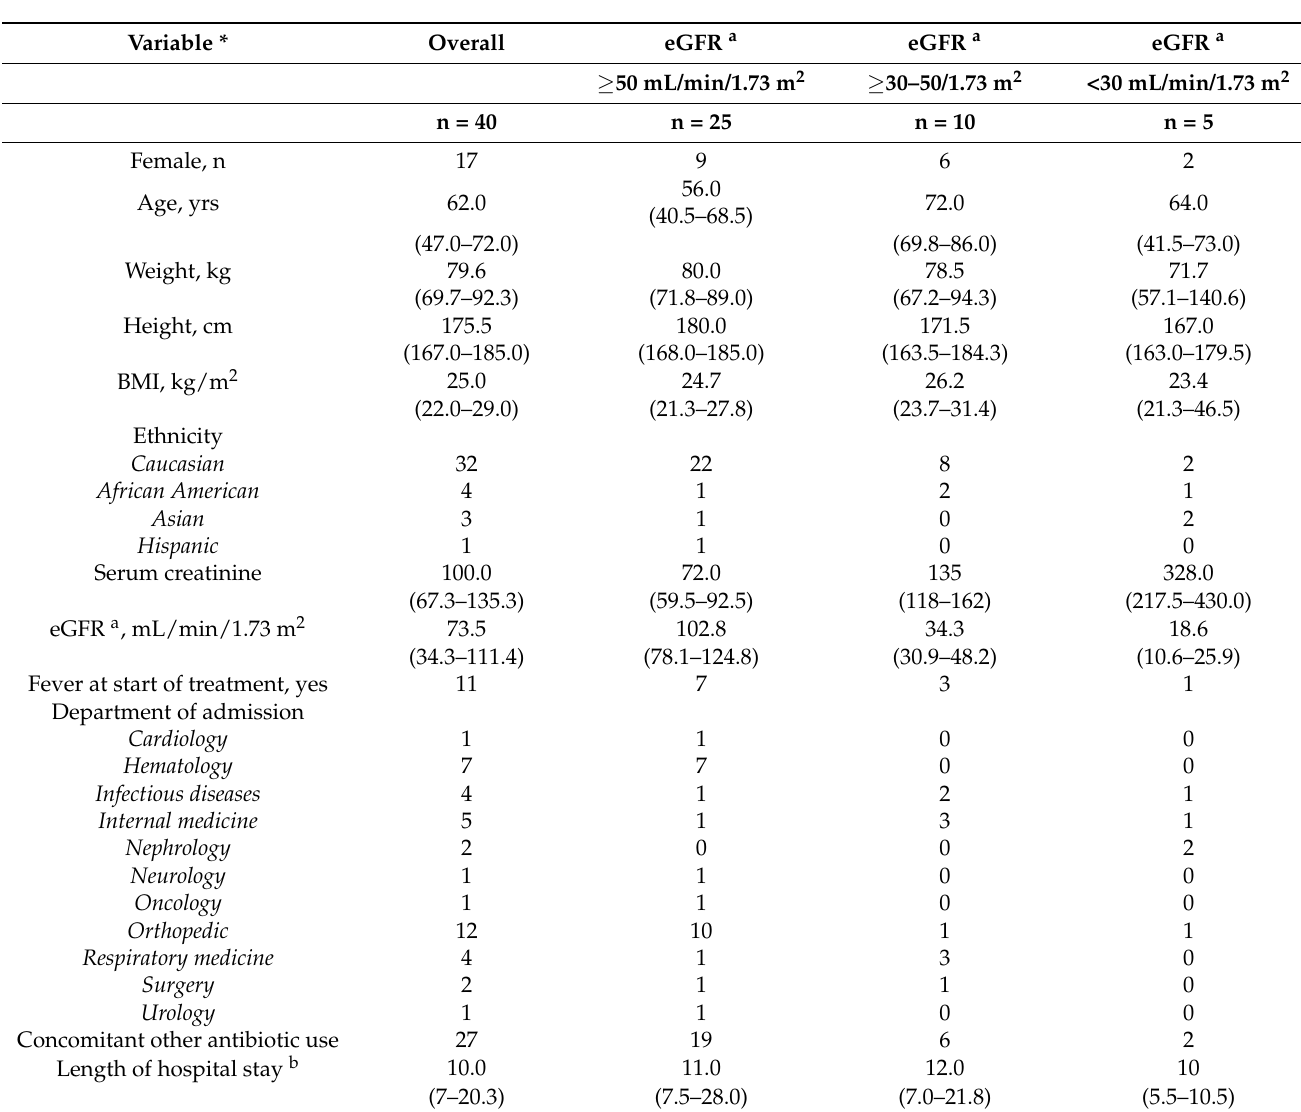
Table 2. Baseline characteristics (n = 40) of the included patient population. Patients were classified according to their renal function expressed as eGFR (CKD-EPI) on the day of